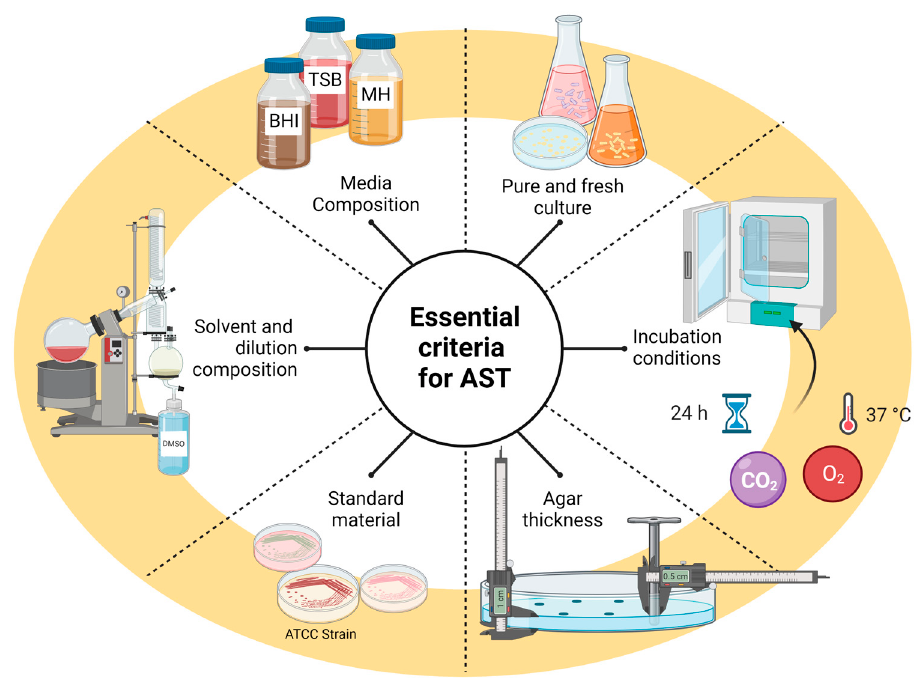
Figure 1. Key considerations to assess Antibacterial Susceptibility Tests (AST) in natural compounds; BHI: Bain heart infusion, TBS: Tryptic soy broth, MH: Mueller Hinton, ATCC: American Type Culture Collection, DMSO: Dimethyl sulfoxide.